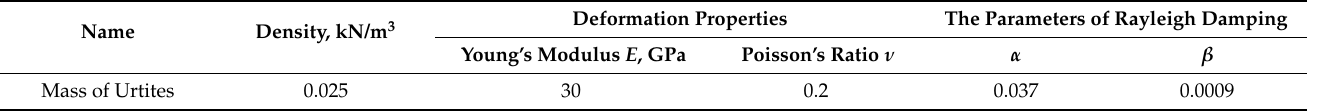
Table 3. Physical and mechanical properties of rocks [15].